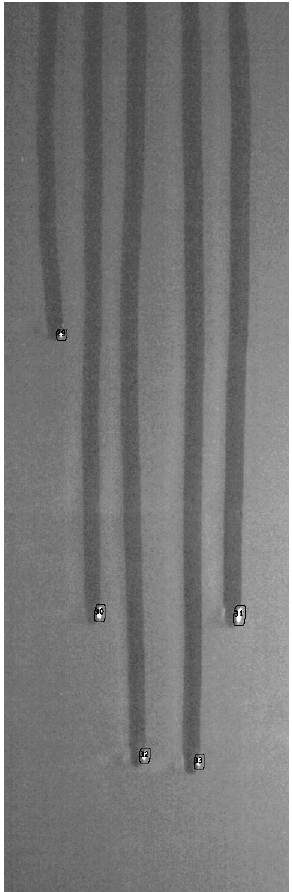
Figure 6: Water droplet sliding along frosted glass in- clined at 65 ◦ . The droplet volumes are 30, 40, 50, 60 and 70 µ L from bottom to top. The downhill direction is towards the bottom of the figure. The numbers in the figure come from the image